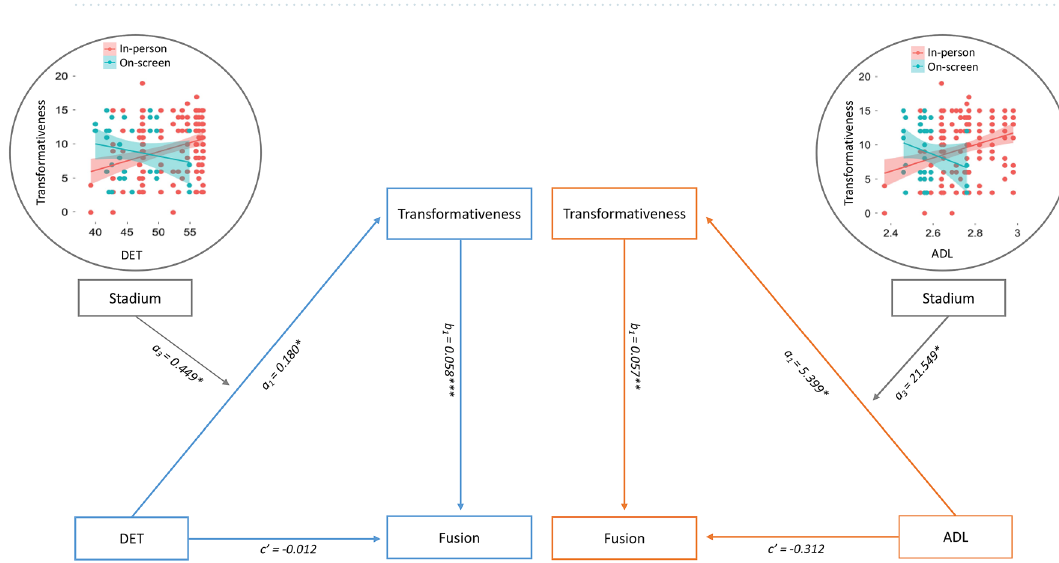
Figure 5. Moderated Mediation Model. Watching events in-person moderates the effect of group heart synchrony on self-transformativeness, which in turn leads to social